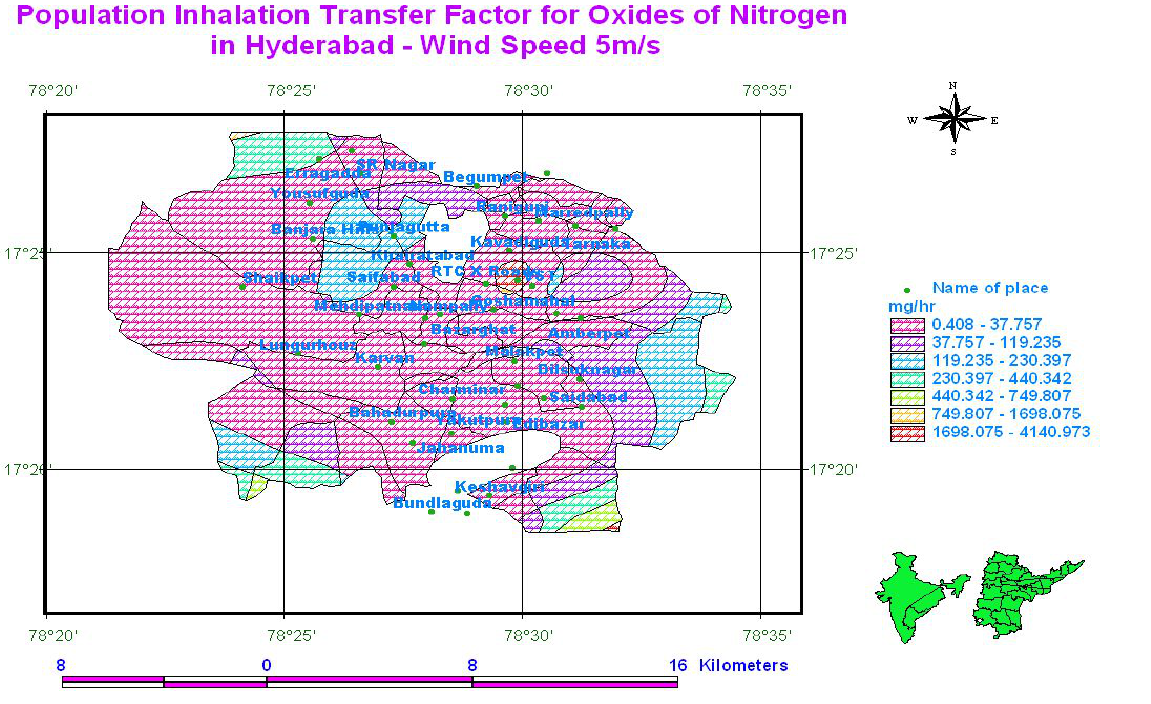
Figure 14: Population inhalation transfer factor for oxides of nitrogen in Hyderabad – wind speed 5m/s